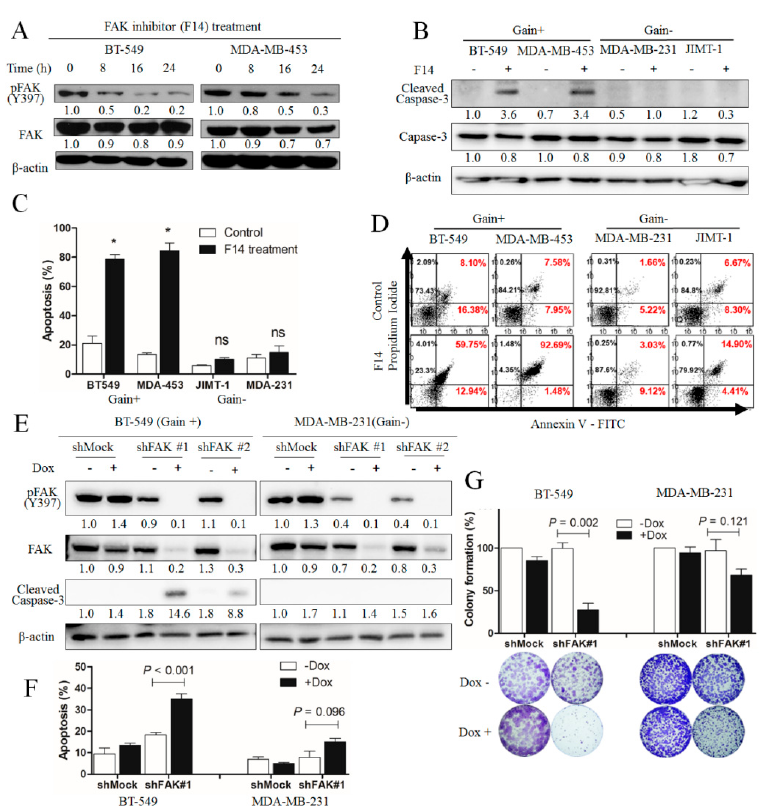
Figure 3. Induction of apoptosis by FAK inhibition in FAK-copy-gain breast cancer cells. ( A ) Decrease of activated or phosphorylated FAK (pFAK) at Y397 by F14 treatment (10 μ M) in a time-dependent manner in Western blotting analysis of both BT-549 and MDA-MB-453. ( B ) Specificity of caspase-3 cleavage in FAK-copy-gain cells (Gain+, BT-549 and MDA-MB-453) compared with no FAK-copy-gain cells (Gain-, MDA-MB-231 and JIMT-1) by F14 treatment (10 μ M, 6 h) in Western blotting analysis. For A and B, β -actin was used as a loading control. Representative images of the three independent experiments are shown. ( C ) Significantly higher apoptosis by F14 (10 µ M, 24 h) in FAK-copy-gain cells (*, P < 0.001) in flow-cytometric analysis. Values represent mean ± standard deviation ( N = 3). ns, not significant. ( D ) Representative images of flow-cytometric analysis for the percentage of annexin V-positive cells in C. ( E ) Higher caspase-3 cleavage in BT-549 by induction of FAK